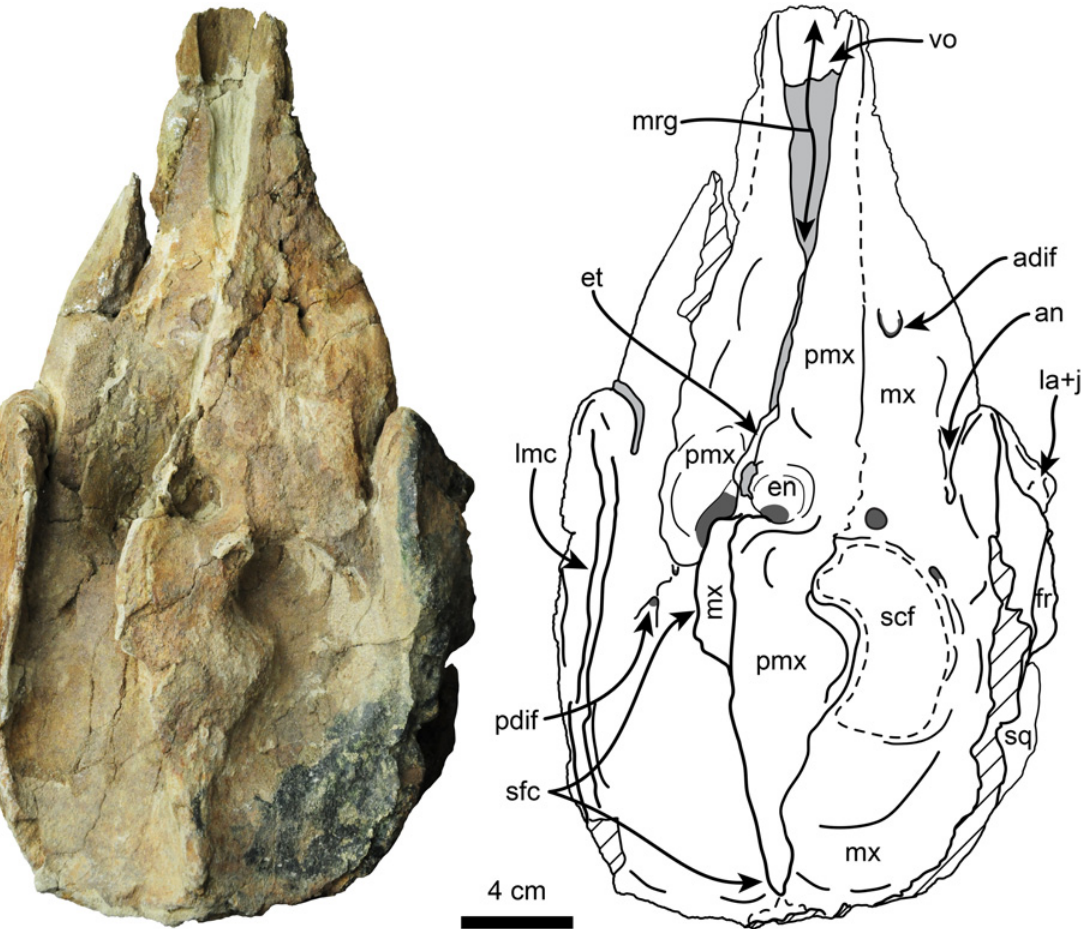
Fig 2. Dorsal view of holotype skull of Nanokogia isthmia gen. et sp. nov. (UF 280000). Abbreviations: adif, anterior dorsal infraorbital foramen; an, antorbital notch; en, external nares; et, ethmoid; fr, frontal; la+j, lacrimal + jugal; lmc, lateral maxillary crest; mrg, mesorostral groove; mx, maxilla; pmx, premaxilla; pdif, posterior dorsal infraorbital foramen; scf, supracranial fossa; sfc, sagittal facial crest; sq, squamosal; vo, vomer. Gray shaded areas indicate sediment; diagonal lines denote broken surfaces. Gray shaded areas indicate sediment; diagonal lines denote broken